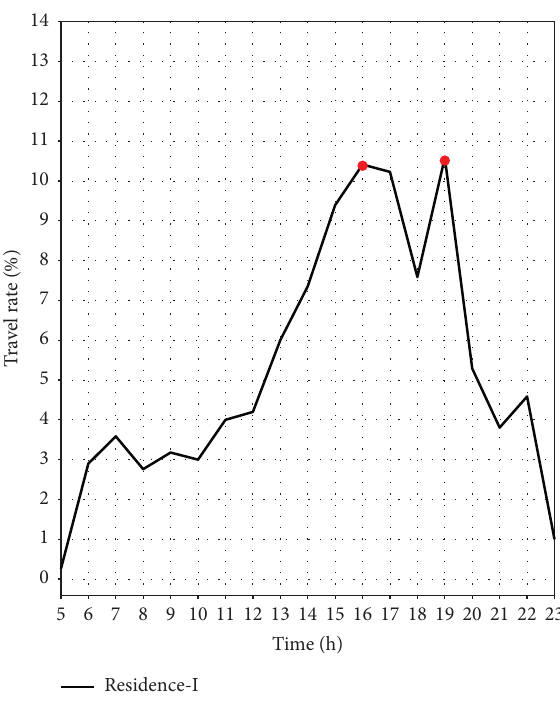
Figure 12: Hourly travel rate of cluster